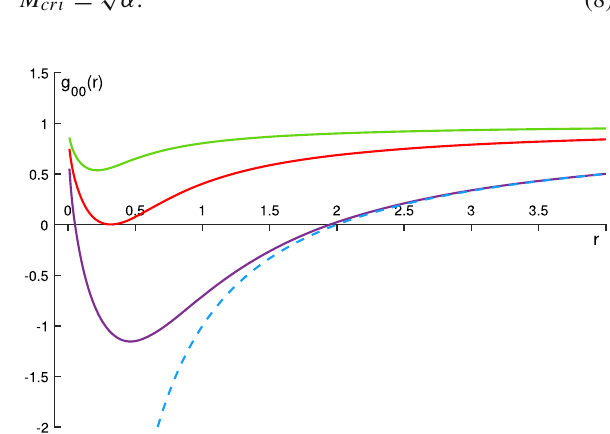
Fig. 1 Plot of g 00 ( r ) versus r for asymptotically flat EGB black hole (with α = 0 . 1). Purple line: M > M cri , there is the white hole and the black hole horizons. Red line: M = M cri , there is the merged horizon. Green line: M < M cri , there is no horizon. In three situation, there are a minimum in gravitational potential located at r 0 where the attractive andrepulsivegravitationalforceisbalanced.Dashedlineshowsgeneral relativity